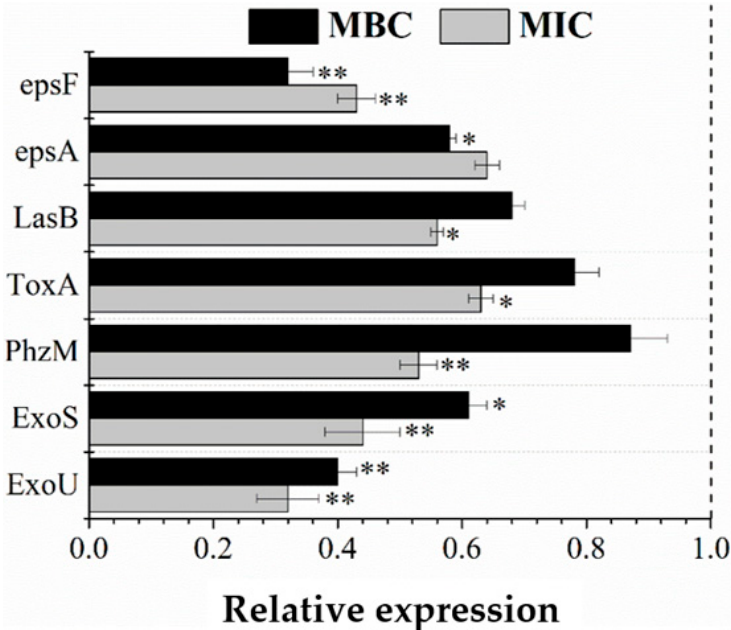
Figure 8. Inhibitory rates of juglone against seven genes. * p < 0.05, ** p < 0.01.